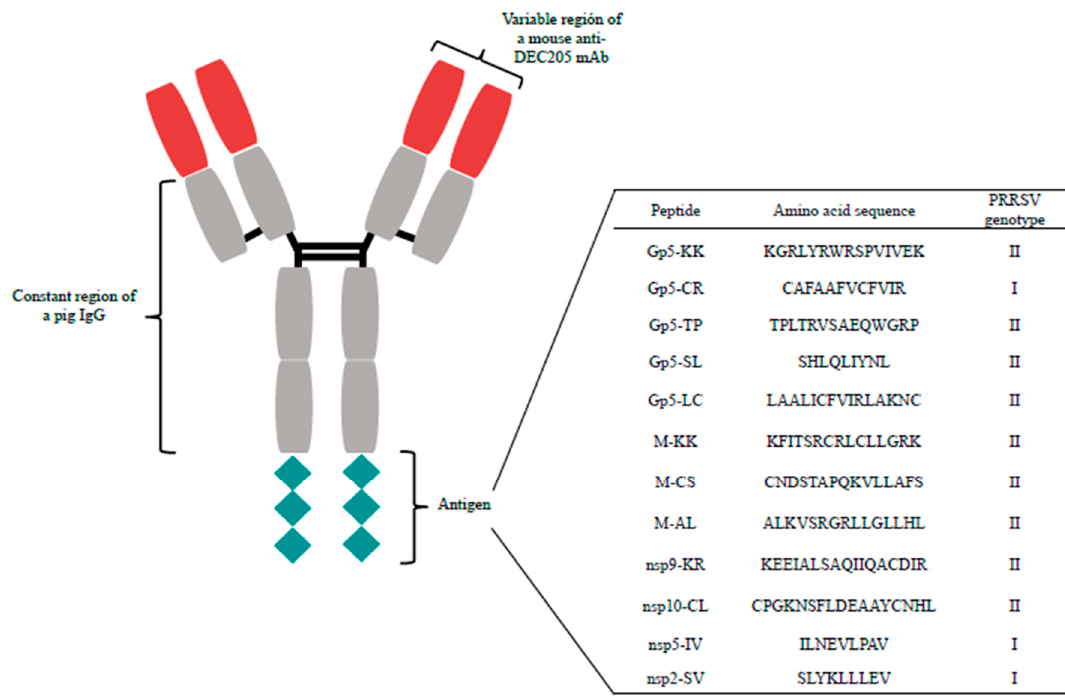
Figure 1. Graphic representation of the recombinant antigenized chimeric mouse x pig antibody utilized. In blue: variable region of a mouse anti-DEC205 monoclonal antibody. In gray: constant region of a pig IgG. The antigenized part consists of a chimeric protein based on selected immunogenic peptides from PRRSV